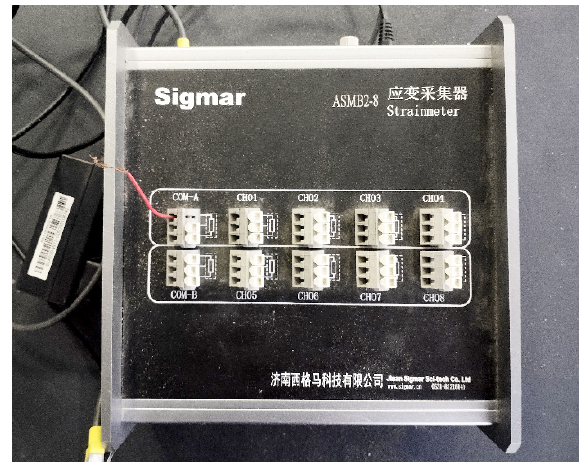
Figure 2. The ASMB2-8 static strain meter.